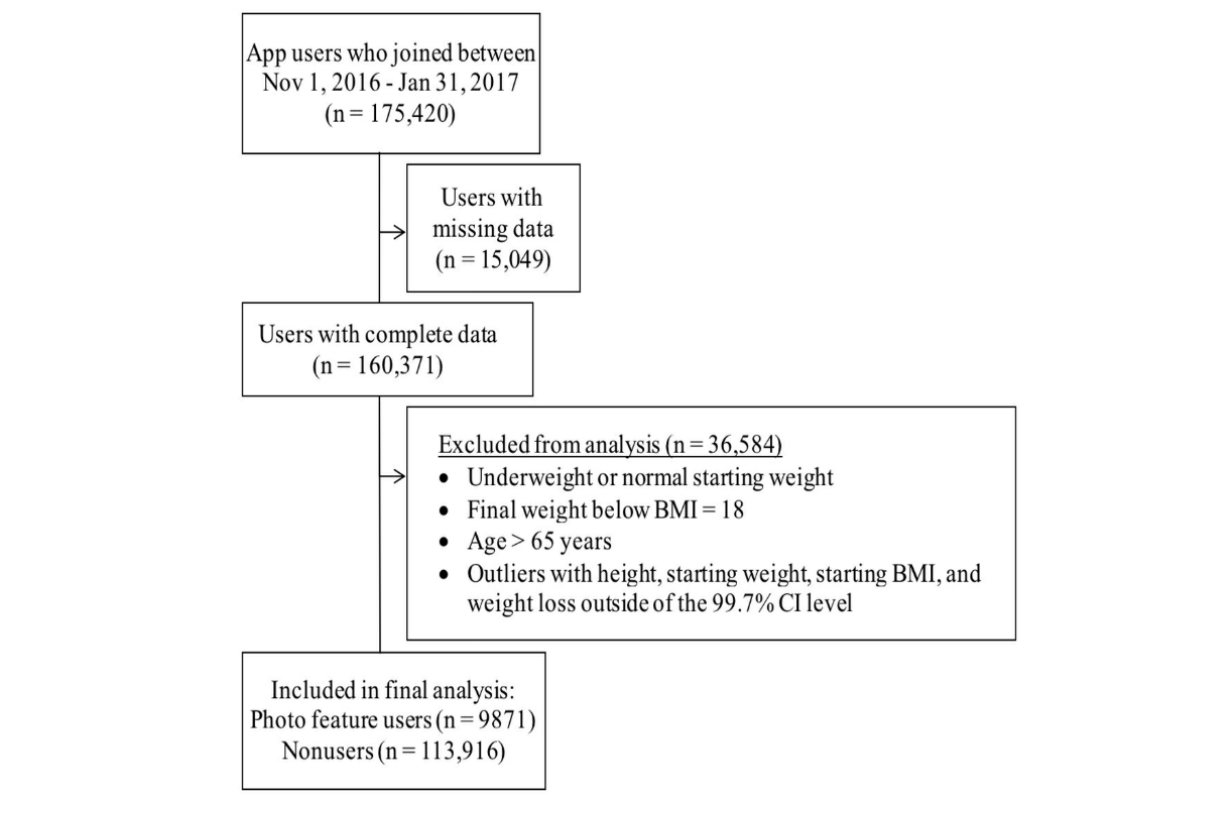
Figure 2. Flow chart of Lose It! app users in the study. BMI: body mass index.